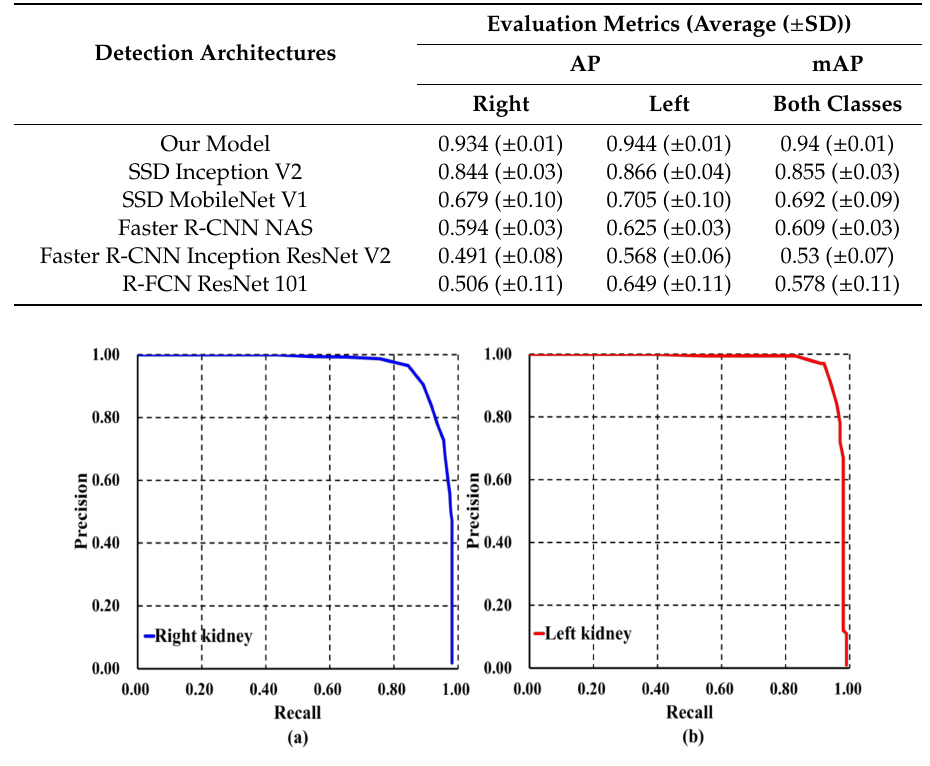
Figure 6. Precision-recall curve of our model on image-wise testing set: ( a ) Right kidney; ( b ) Left